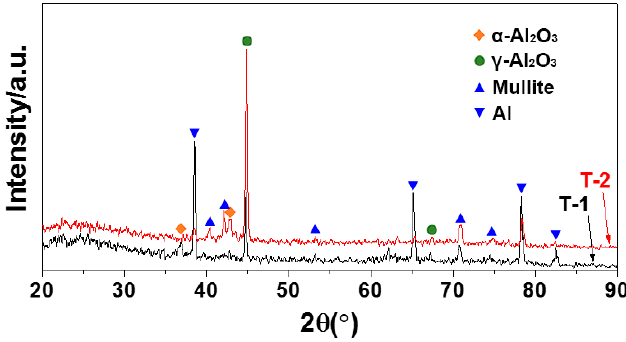
Figure 9. XRD spectra of MAO layers formed on TA2 substrates after hot-dip